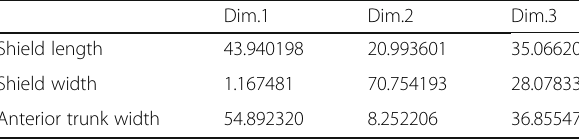
Table 2 Factor loadings of PCA Dim.1 Dim.2